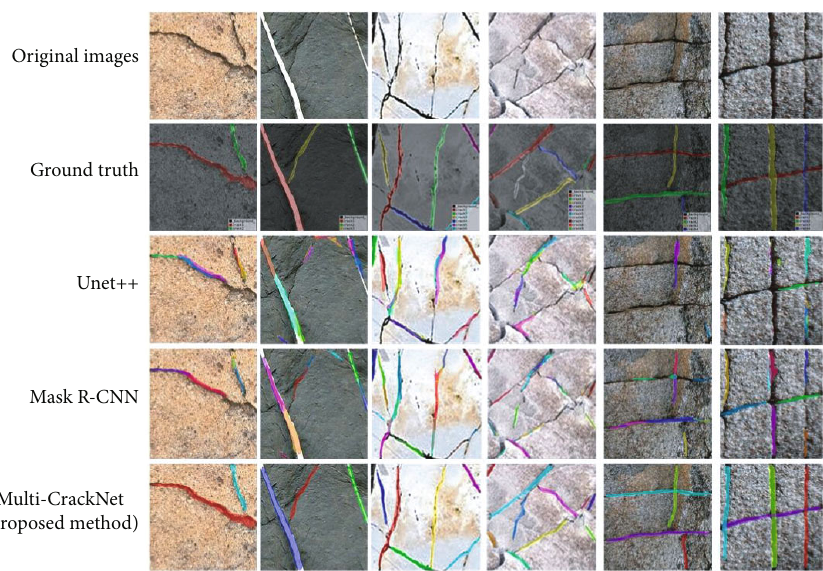
Figure 19: Comparative studies among multi-CrackNet, Unet++ [47], and mask